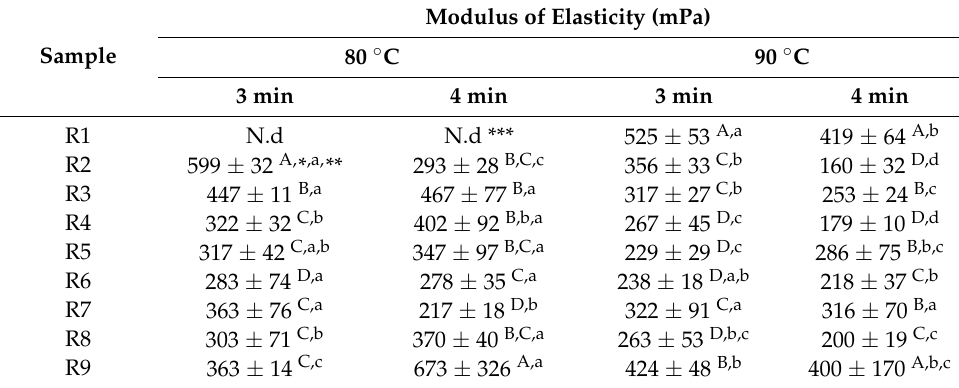
Table 3. Modulus of elasticity (E) of the rice noodle strands.